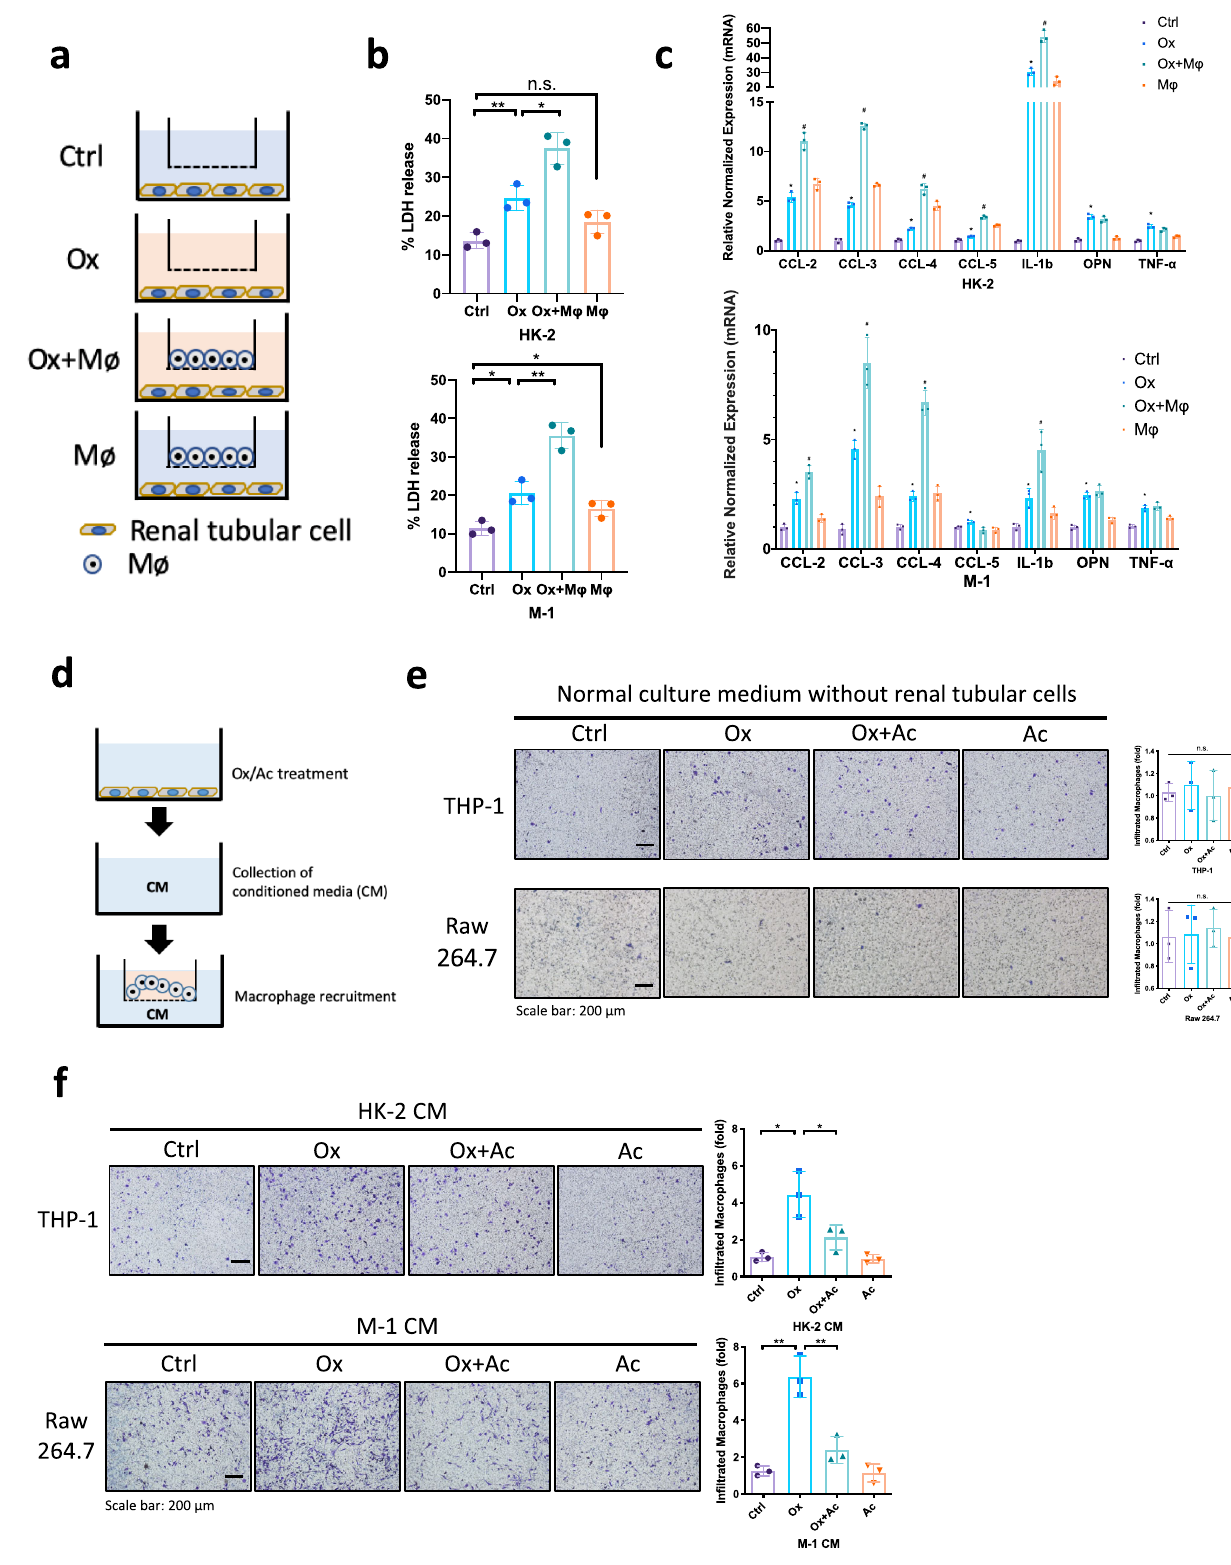
mRNA, and generated a luciferase reporter construct bearing the 3 ′ UTR of MIF gene using a dual-luciferase reporter as well as a mutated version at the predicted target sites. The luciferase assay results revealed that miR-493-3p could suppress luciferase expression of the wild-type MIF 3 ′ UTR construct, but not the